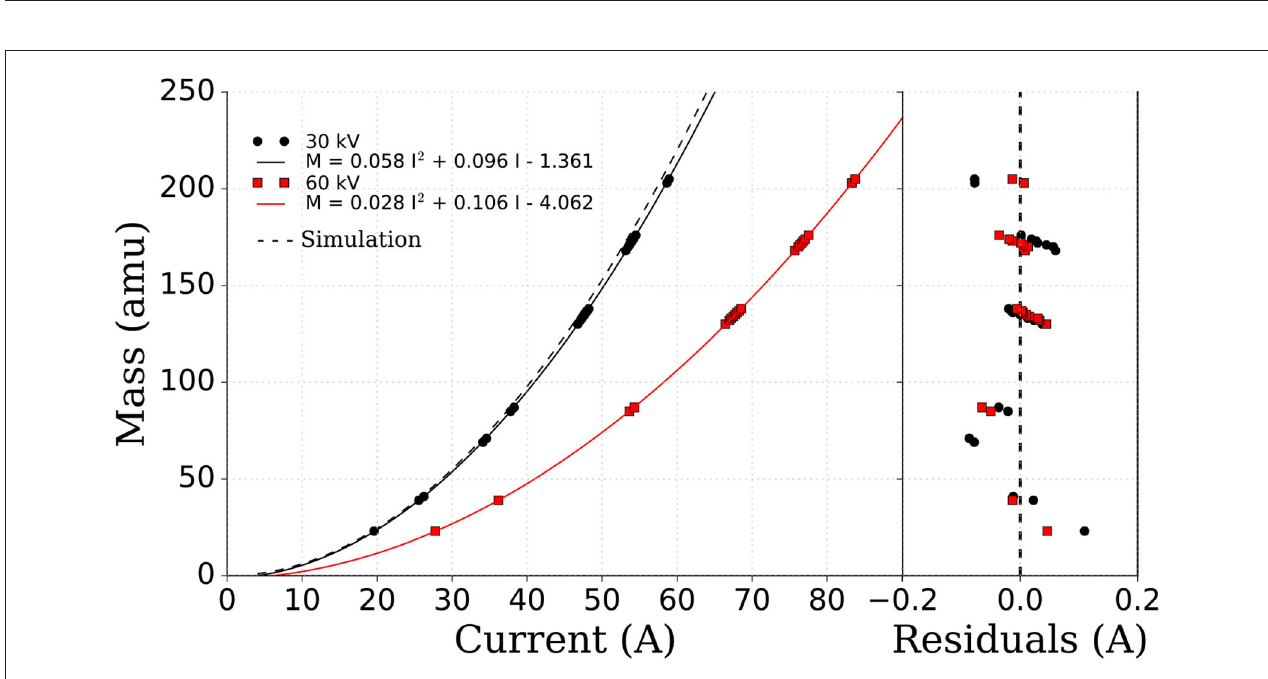
FIGURE 6 | Comparison between OPERA models without and with the drilled hole necessary for the laser beam access (no hole—symbols/with hole—solid lines) for three different values of the current I (A), needed to have masses A/q = 1, 100, and 300 in the central trajectory, respectively (Left) . Relative integrated field error [10 − 4 ] for I = 70.3 which corresponds to A = 300 amu at 30 keV for a magnet with the laser window incorporated (Right) .